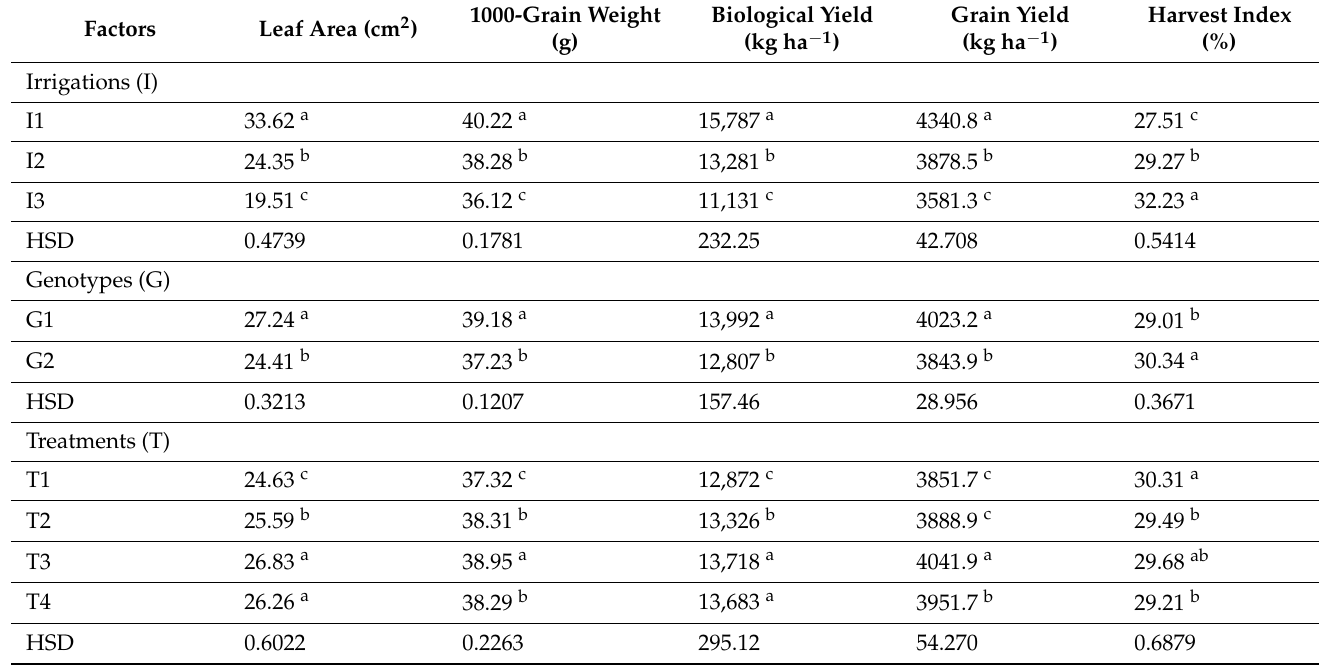
Table 7. Impact of NPK and organic amendments on leaf area, 1000-grain weight, biological yield, grain yield and harvest index of triticale genotypes cultivated under various irrigation